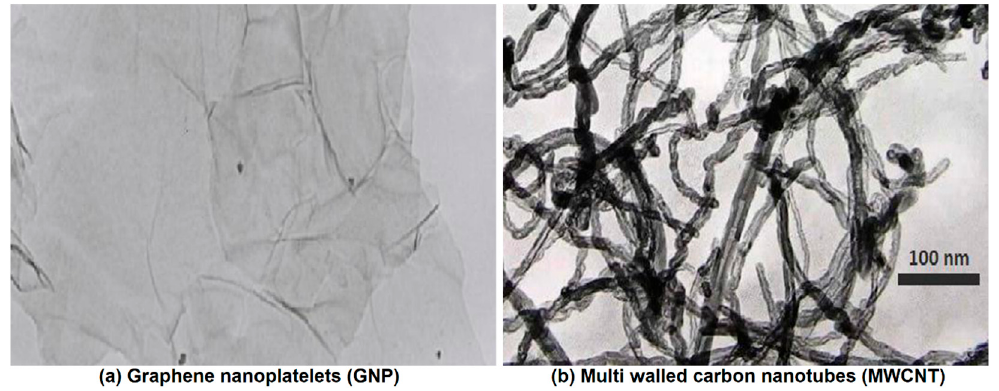
Figure 2. TEM images of nanoparticles and the nanofluids: ( a ) GNP and ( b ) MWCNT